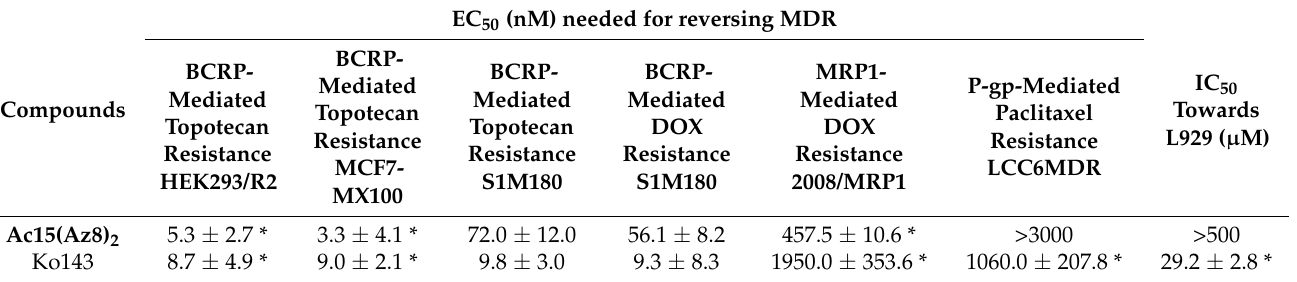
Table 2. EC 50 of Ac15(Az8) 2 or Ko143 for reversing BCRP-, MRP1- and P-gp-mediated drug resistance. EC 50 (nM) needed for reversing